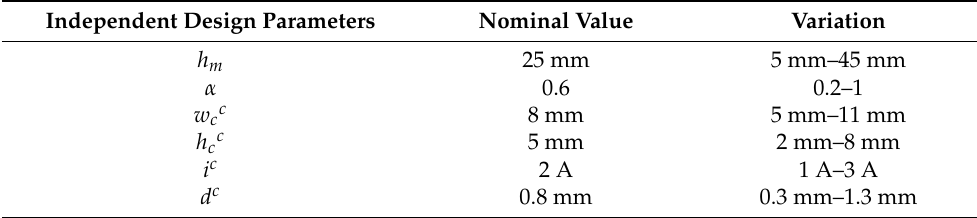
Table 3. Variations in the design parameters of the planar motor for sensitivity analysis.